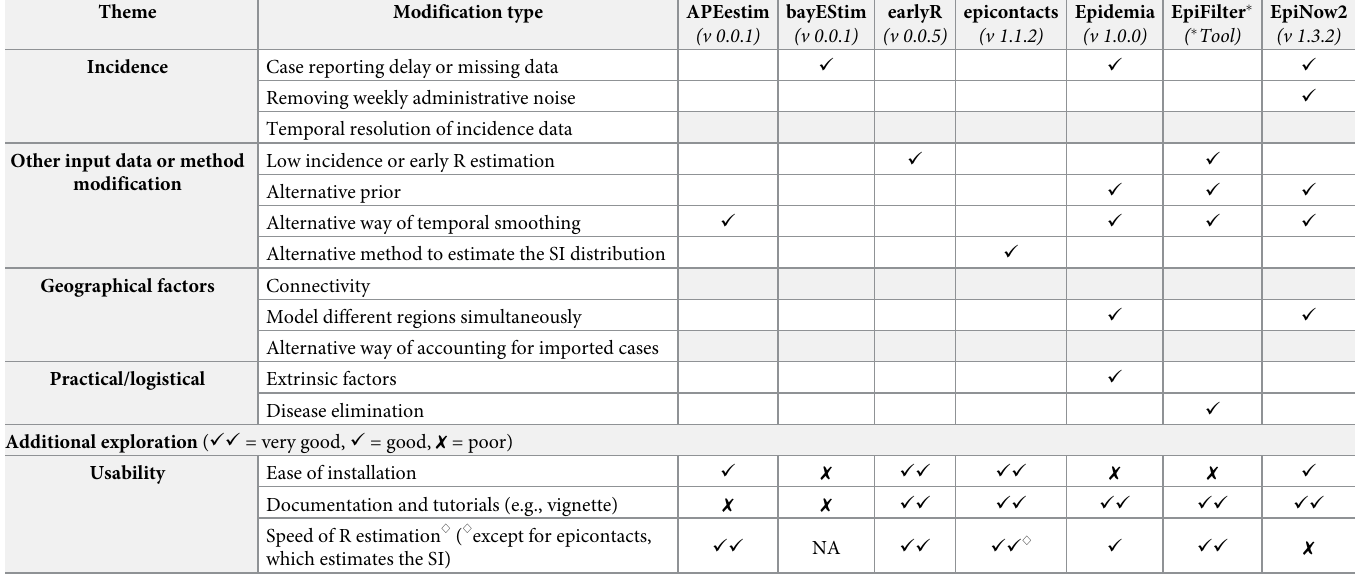
Table 2. Summary table of the R packages and tool ( � ) that address some of the issues identified in the scoping review. The ticks ( ✓ ) indicate whether an R package includes that modification type and rows that are grey show the modification types that have not been incorporated into a known R package or tool. The final three rows summarise additional exploration by the authors to assess how easily each package/tool can be installed and used. For full details of how each classification (very good = ✓✓ , good = ✓ , poor = ✗ ) was defined, see Table B in S1 Text and the associated text (section